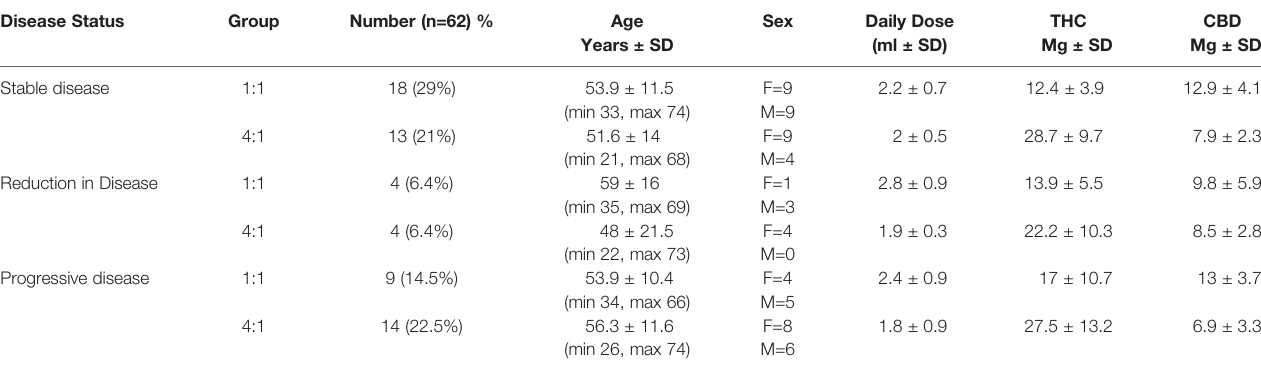
TABLE 2 | Group and Dose response to disease outcome over 12 weeks. Disease Status